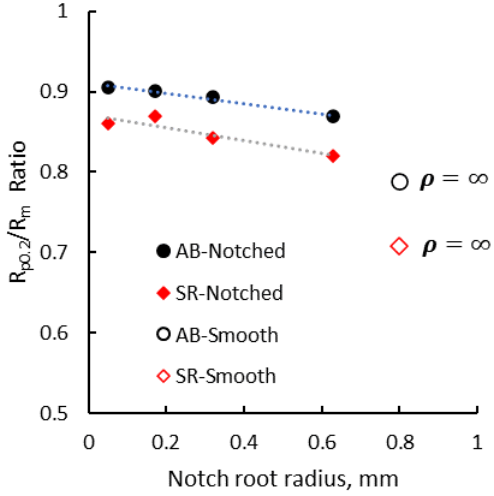
Figure 12. R p02 / R m ratio of V-notched and smooth specimens vs. notch root Figure 12. R p02 /R m ratio of V-notched and smooth specimens vs. notch root radius.